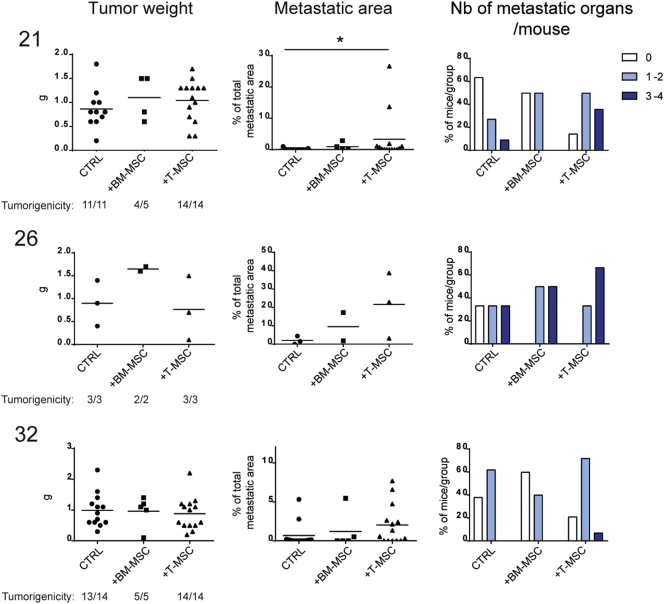
T-MSCs promote the metastatic potential of paired primary lung cancer cells more efficiently than BM-MSCs.Results from mouse injections with 21, 26 and 32 primary tumor cells alone (CTRL) or in the presence of BM-MSCs (from one healthy donor, BM1) or paired T-MSCs. For 21 and 32 tumors, 2 independent experiments were performed and data pooled together. Numbers of total injected mice per group are indicated as the denominator for the assessment of tumorigenicity. For each group, the tumorigenic ability is reported as the ratio between the number of mice with tumors to the total number of injected mice. Mice without tumors (n = 2) were not included in analyses or graphs. Tumor weights (grams, (g); left panels), percentages of total metastatic area per mouse (middle panels) and proportions of mice per group with 0 (white bars), 1–2 (clear blue) or 3–4 (dark blue) metastatic organs (right panels) are depicted for the three groups. Horizontal lines represent mean values. Groups were compared using the nonparametric Kruskal–Wallis (K–W) test with post-hoc Dunn's multiple comparison test. Significant differences are reported as *according to the level of significance (P < 0.5). See also Fig. S2.